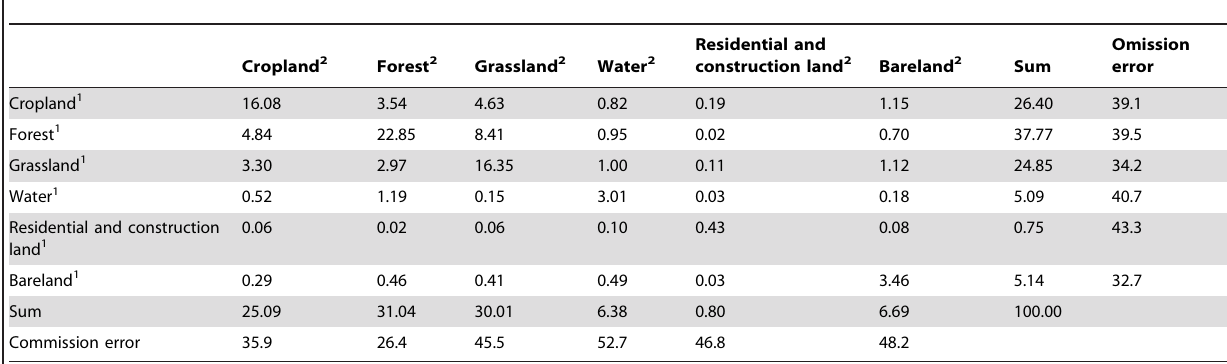
Table 3. Error matrix of the combination model (80%,